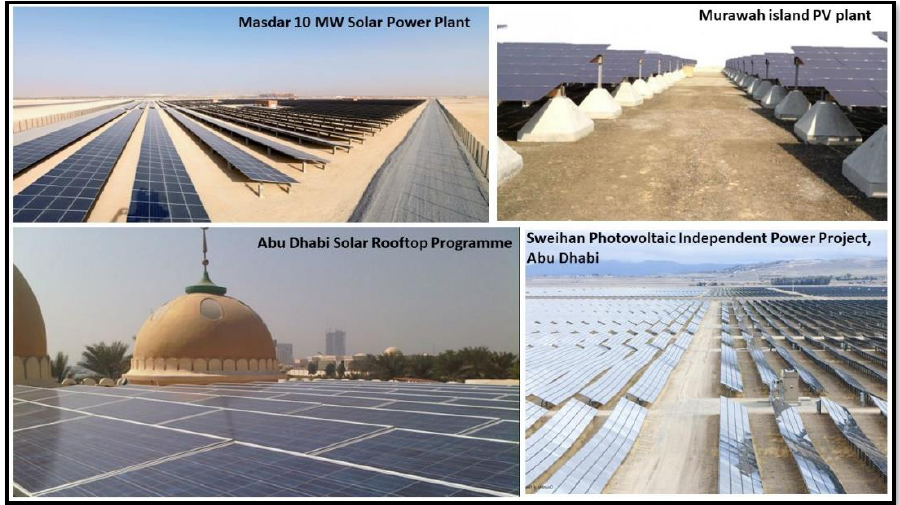
Figure 18. Solar projects in Masdar 10 MW Solar Power Plant, the Murawah Island PV plant, Abu Dhabi solar rooftop program, and the Sweihan Photovoltaic Independent Power Project, Abu